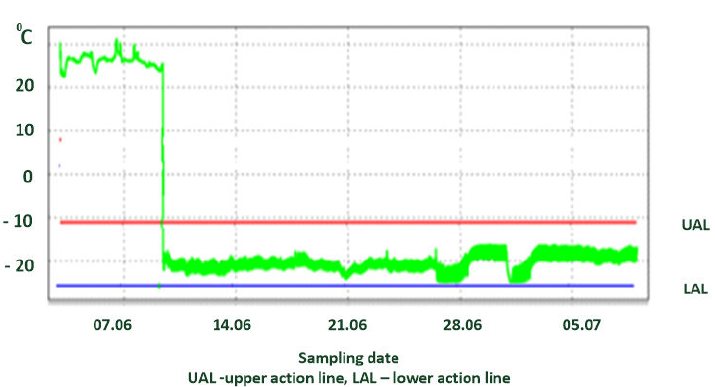
Figure 3. Exemplary temperature fluctuations in a deep freezer with frequent up and down incidents. Source: own experimental